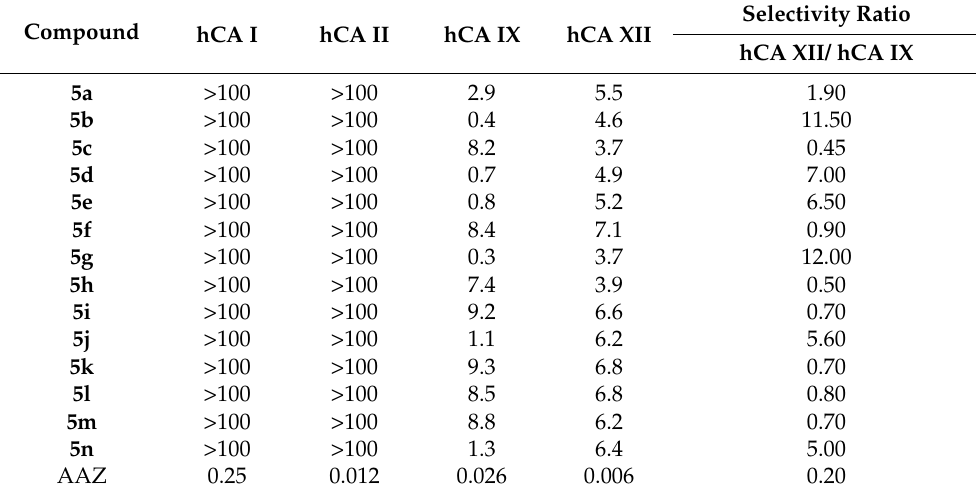
Table 1. Inhibition of hCA isoforms I , II , IX and XII with compounds 5a – n and acetazolamide